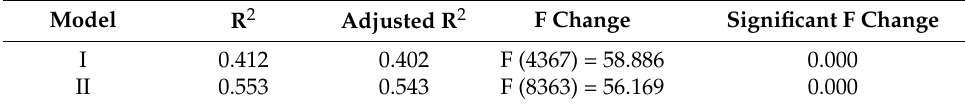
Table 7. Fitting result of multiple regression model.